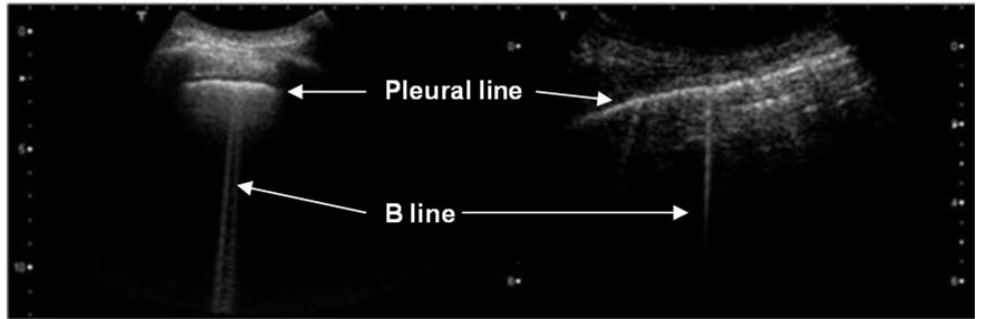
Figure 2. Three examples of B-lines. B-lines are vertical hyperechoic, well-defined and laser beam-like lines that emerge at the pleural level, erasing the A-lines, and move in synchrony with the respiratory cycle. Reprinted/adapted with permission from [10]. 2022, Acoustical Society of